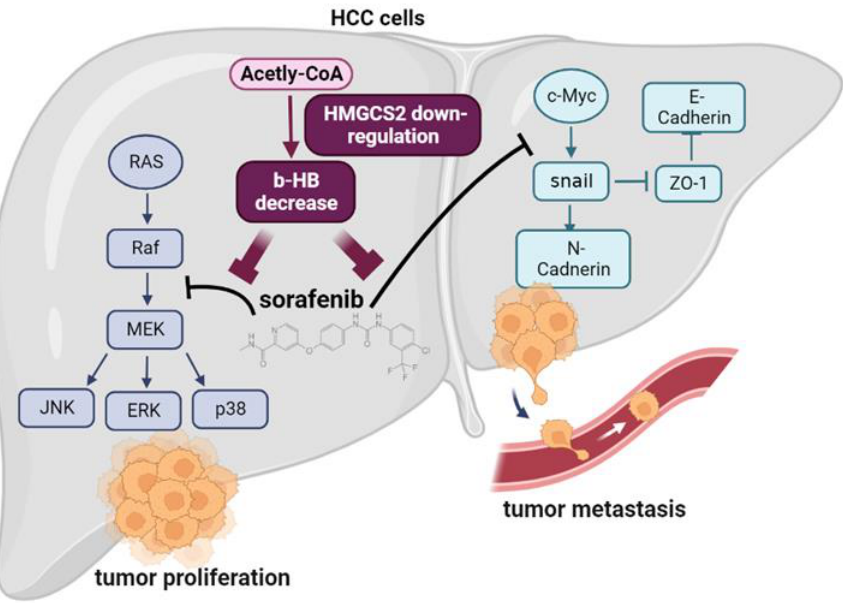
Figure 6. Proposed model demonstrating the mechanisms of HMGCS2 downregulation mediating ketone reduction in influencing the sorafenib treatment efficacy of hepatocellular carcinoma (HCC) cells. The image was created with